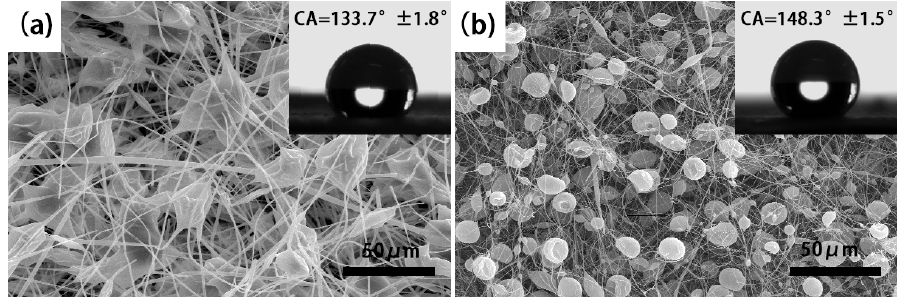
Figure 4. SEM images of the worst ( a ) and best ( b ) hydrophobic membranes in the initial round.